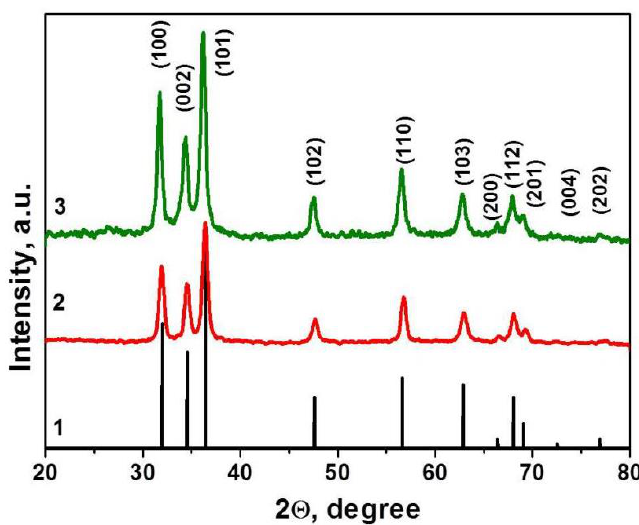
Figure 1. XRD patterns of ZnO–SnO 2 (ZTO) films. ZnO phase (curve 1), Crystallography Open Database (COD) ID 2300113, and material 1 (curve 2), 2 (curve 3).